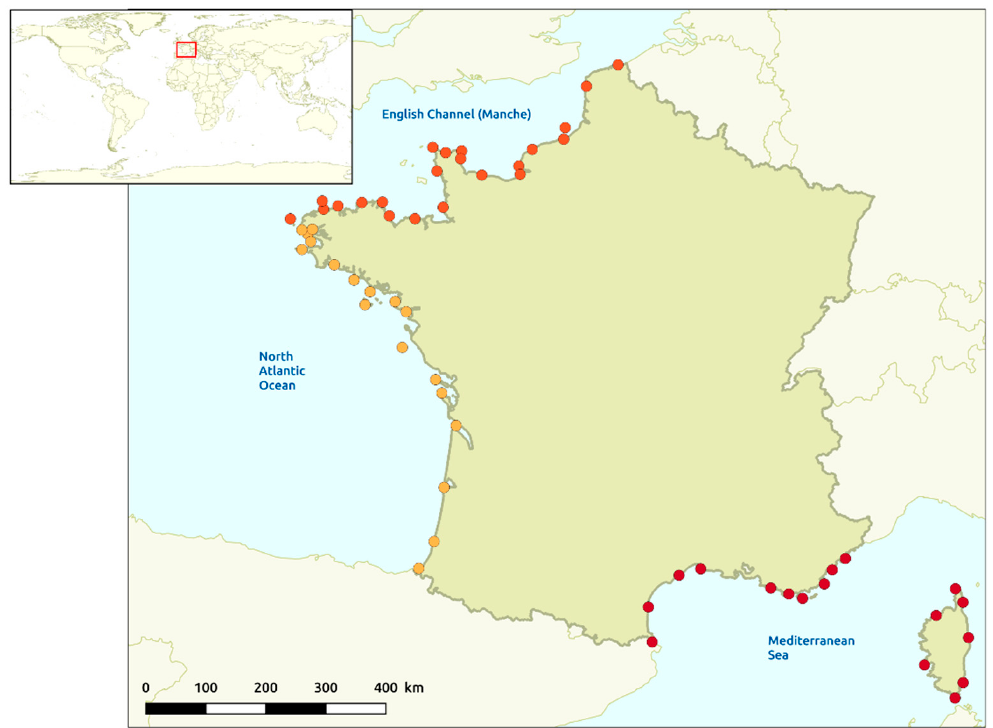
Figure 2. The French network of sémaphores, localization of the installations.